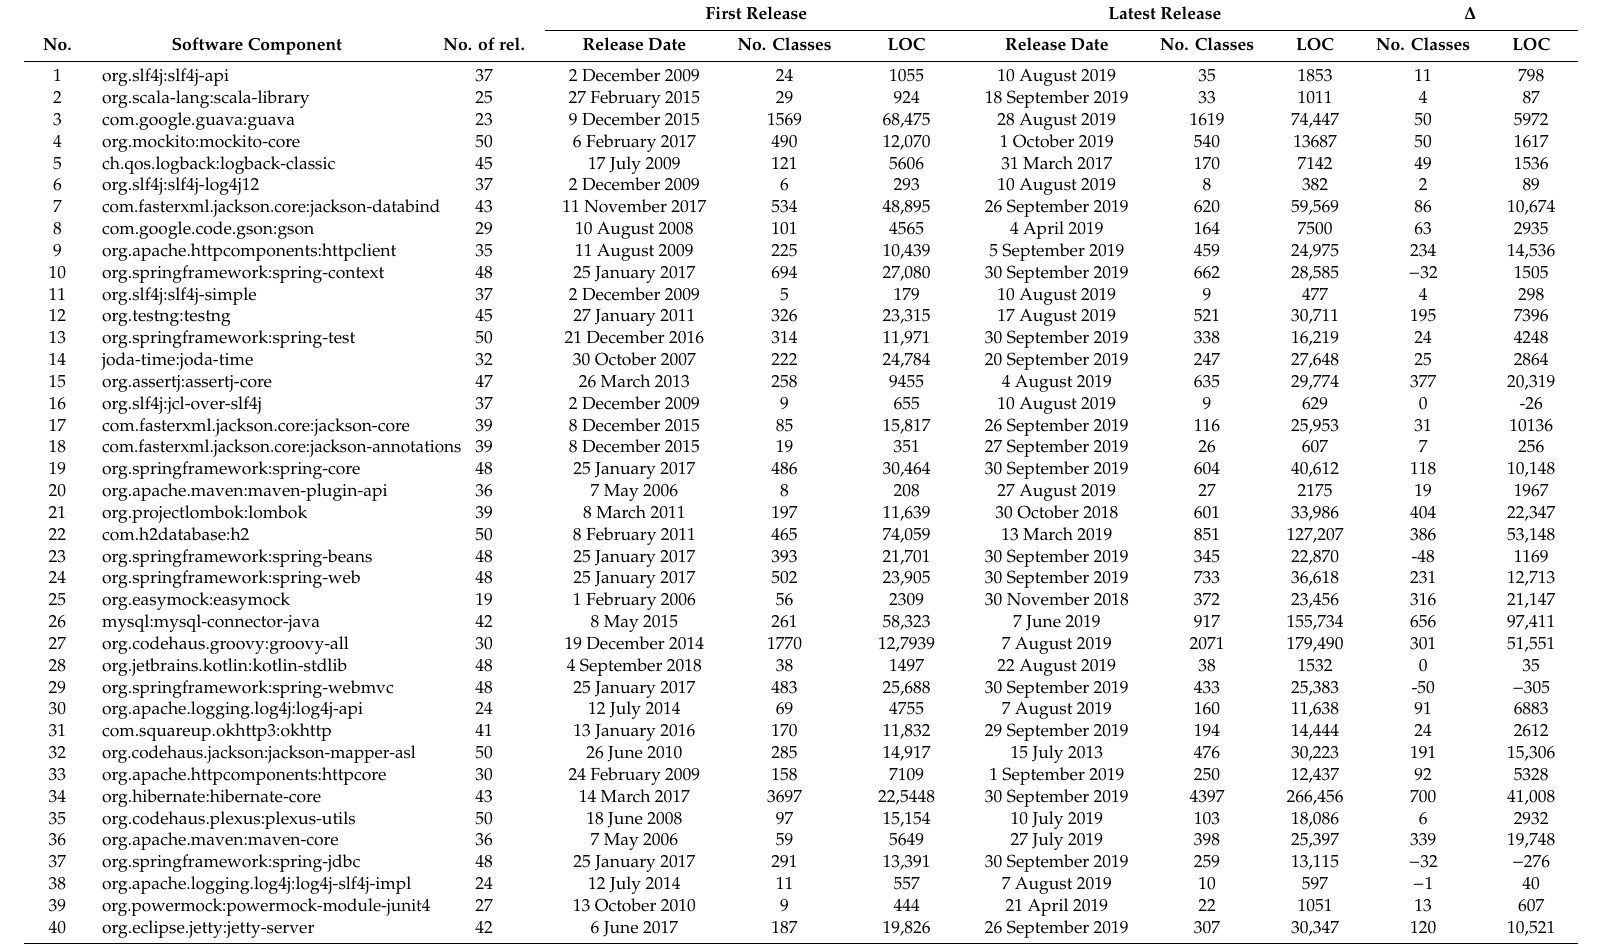
Table A1. Details about open source